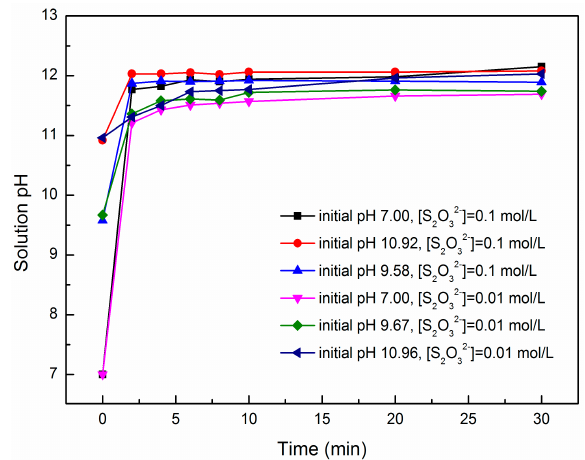
Figure 1. Variations of pH on Hg extraction in 0.01 mol/L and 0.1 mol/L Na 2 S 2 O 3 solution (Initially, 0.4 g HgO was mixed with 500 mL Na 2 S 2 O 3 solution, 20 ± 1 ◦ C).